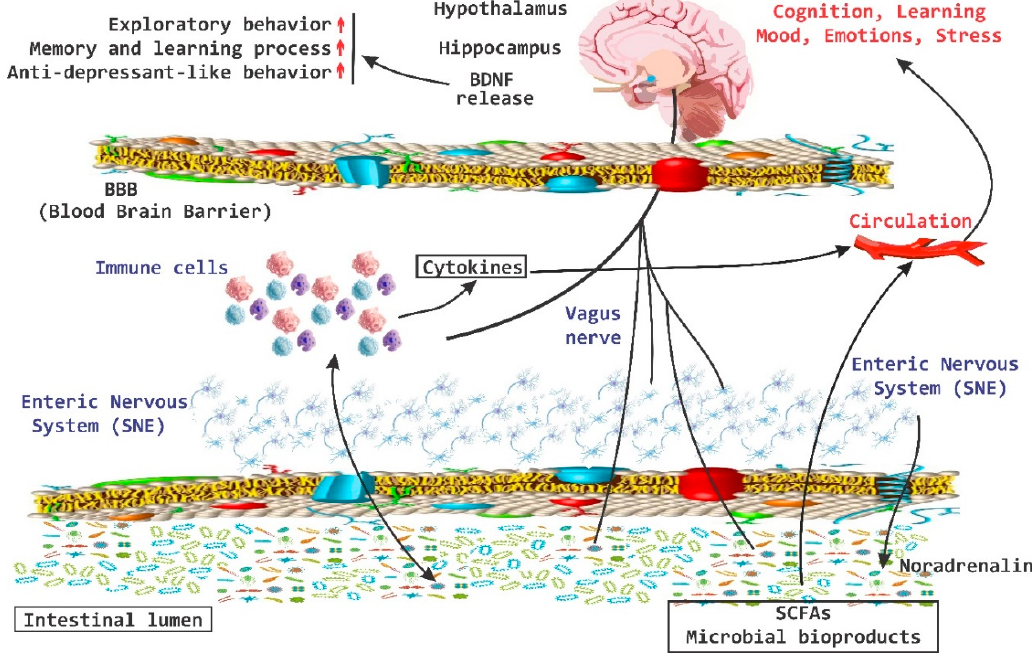
Figure 6. BDNF release system. The brain-derived neurotrophic factor (BDNF) released via the activation of the brain-gut axis has been associated with cognitive and behavioral processes, as well as with anxiolytic and antidepressive effects. SCFAs, short chain fatty acids; red arrow up mean increase levels.